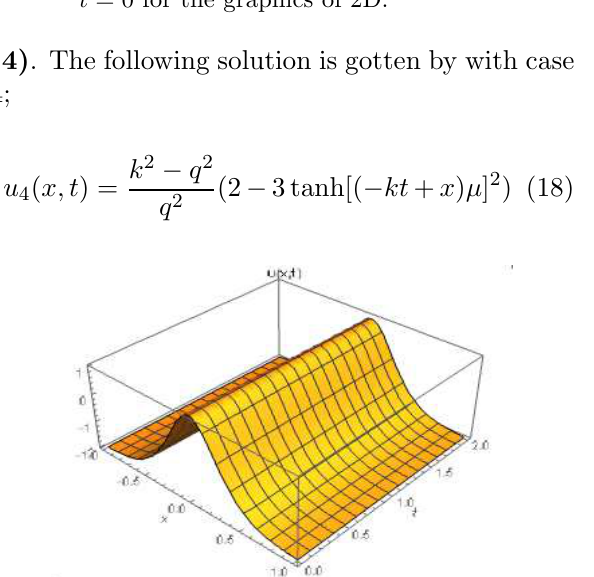
Figure 4. The 2D and 3D shape for the imaginary and real part of Eq. (17) with the values k = 2, p = 1, c 0 = 1, 5 < x < 5, 0 < t < 2 and − t = 0 for the graphics of 2D.